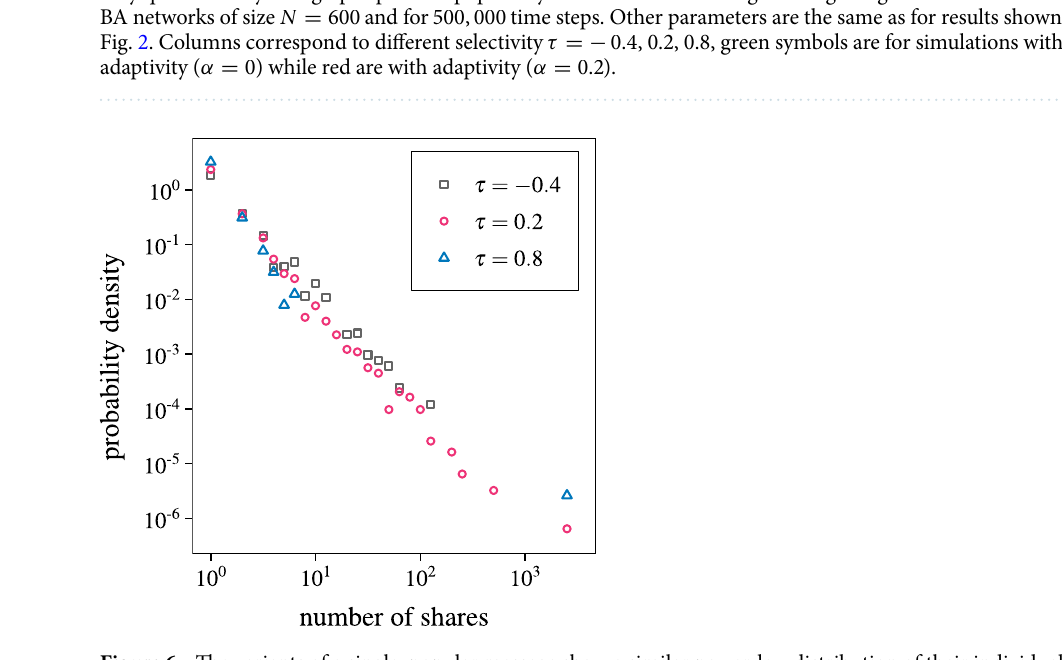
Figure 6. The variants of a single, popular message show a similar power-law distribution of their individual variant popularity. The figure shows the variant popularity distributions for different selectivity parameters τ = − 0.4 (gray squares), τ = 0.2 (red circles) and τ = 0.8 (blue triangles). Simulations were conducted on ER networks with N = 10, 000 , � k � = 6 and 500, 000 time